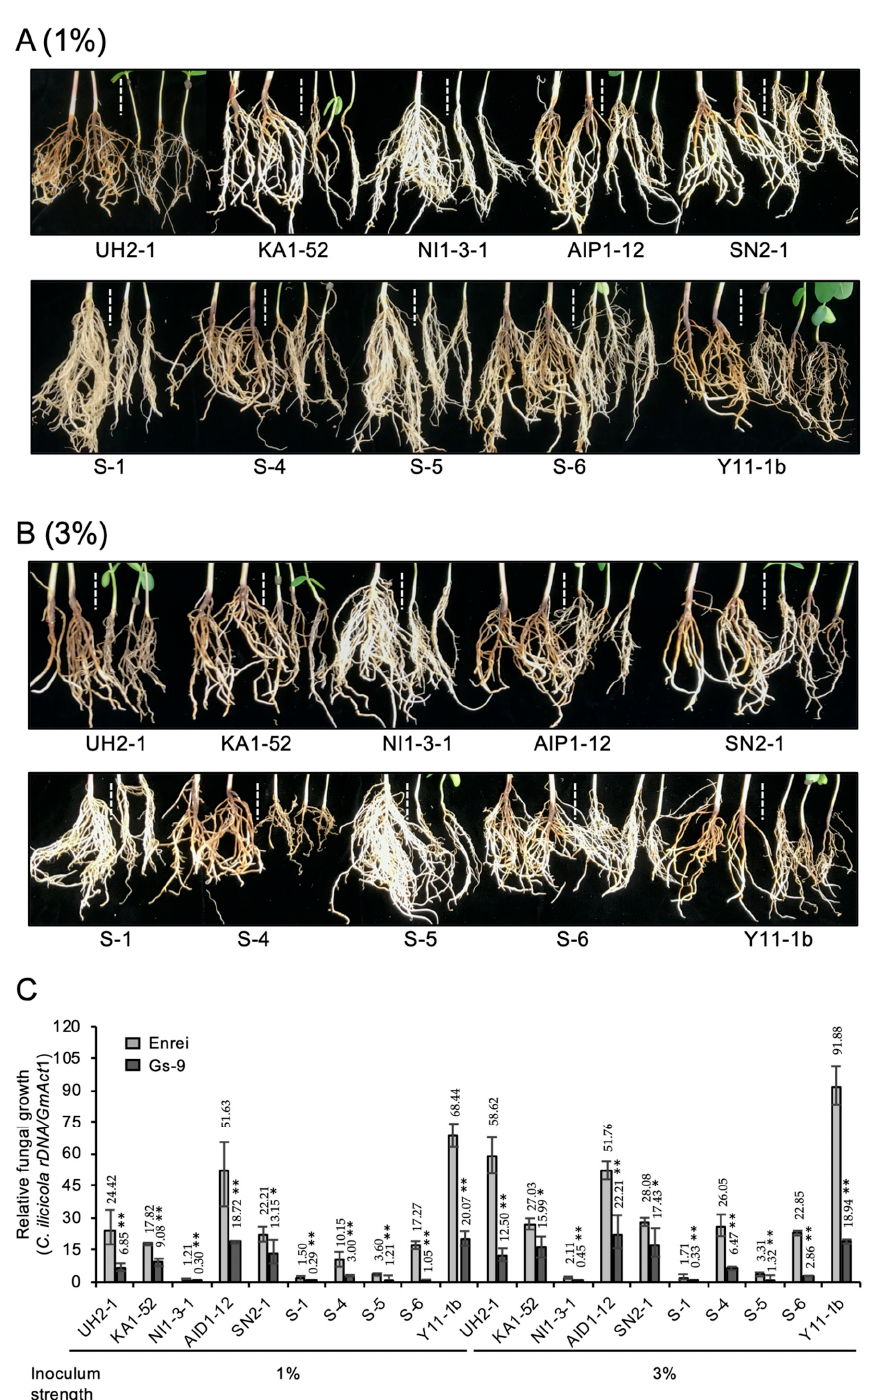
Figure 5. Evaluation of the resistance of wild soybean accession Gs-9 (JP30159) to 10 di ff erent isolates of Calonectria ilicicola . ( A , B ) Images of disease incidence at 1% ( A ) and 3% ( B ) of inoculum concentrations, respectively, in control soybean “Enrei” (left of the vertical dotted line) and wild soybean accession Gs-9 (right of the vertical dotted line, JP30159). ( C ) Relative fungal growth in roots of soybean Enrei (grey bars) and the C. ilicicola -resistant wild soybean Gs-9 (black bars) at 1% and 3% inoculum strengths respectively. Data were recorded 14 days after inoculation with 10 di ff erent isolates of C. ilicicola , as indicated on the figures. Values are means ± SD, n = 3 replicates of 5 individuals each. Asterisks denote a significant di ff erence to the Enrei control plants (non-parametric t -test, * p < 0.05, ** p <